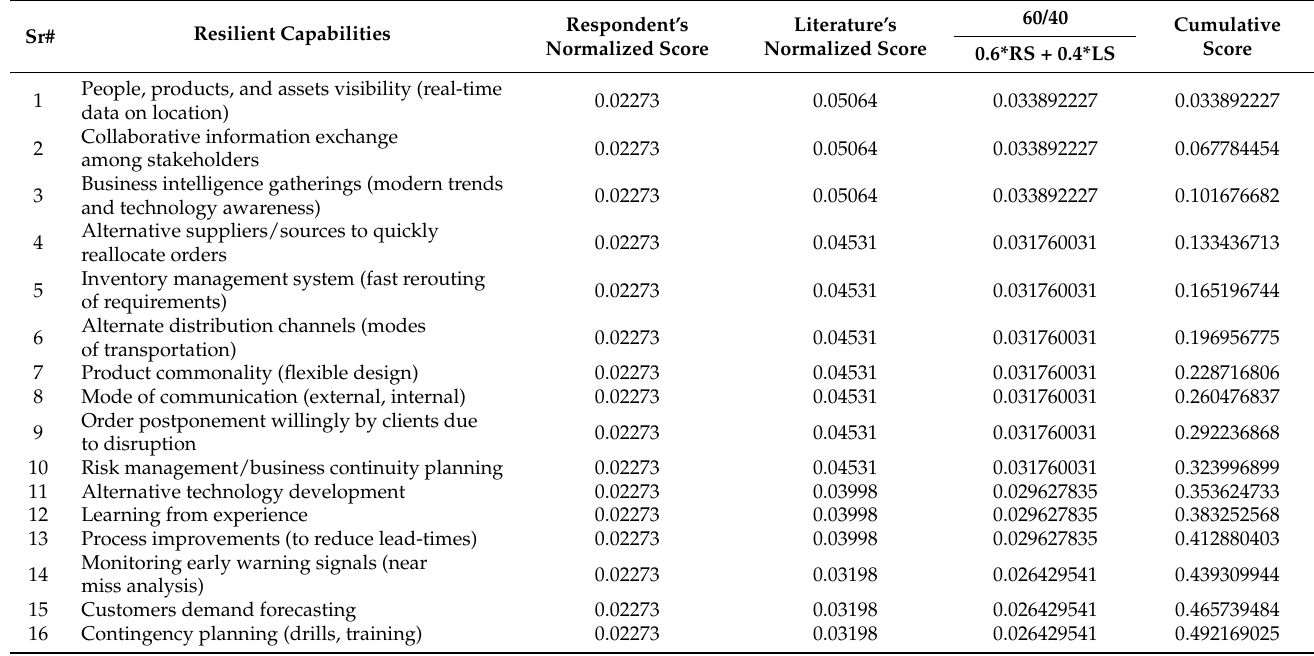
Table 3. Shortlisted resilience capabilities with normalized and cumulative